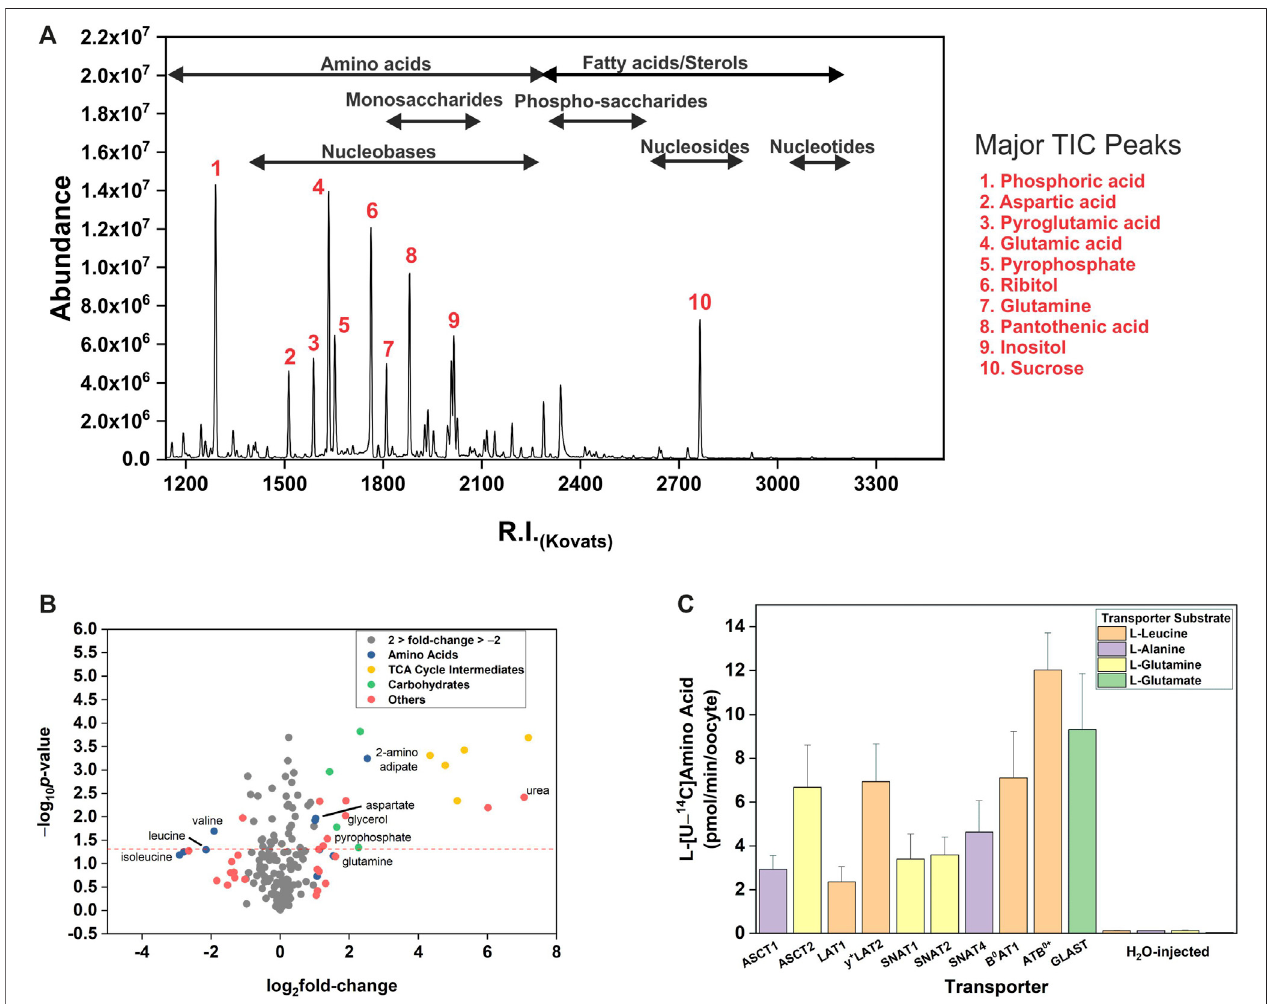
FIGURE1| Metabolicpro fi le of Xenopuslaevis oocytes. (A) Thetotal ionchromatogram (TIC)ofSouth Africanclawed frog Xenopus laevis oocytes.Theclustersof selectedmetaboliteclassesareindicated.Oocyteswereanalyzed after4 daysincubationin1 × OR 2+ buffer.A3:1:1methanol:chloroform:water extractionprocesswas used followed by automated derivatisation/methoxymation. TIC acquisition was carried out on an Agilent 7890A gas chromatograph coupled to a 5975C single quadrupole mass spectrometer. This TIC is a representative of the un-injected oocytes utilized as controls throughout this study. Numbering and the legend indicate selected abundant metabolite peaks. (B) Un-injected oocytes were incubated in modi fi ed L-15 media for 4 h or remained in OR 2+ followed by metabolite extraction and GC-MS analysis. Each data point in the volcano plotrepresents asingle metabolite. The fi gures are arepresentative example of3repeats ( n (cid:2) 3technical replicates comparing 12 L-15 incubated and 12 OR 2+ incubated oocytes per replicate, e (cid:2) 3). (C) Oocytes were injected with the 5 – 10 ng cRNA encoding transporters as listed. Transport activity was measured by 30 min incubation in 1 × ND96 (pH 7.4) assay buffer spiked with an unlabelled amino acid and 1.0 μ Ci/ml of L-[ 14 C]- or